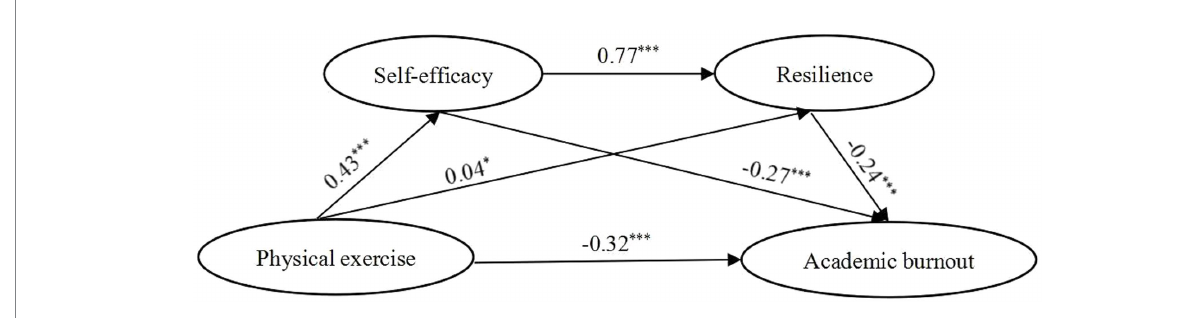
FIGURE 1 Model showing the mediating roles of self-efficacy and resilience in the relationship between physical exercise and academic burnout (Total sample). *** p < 0.001, * p < 0.05; significant standardized regression coefficient.